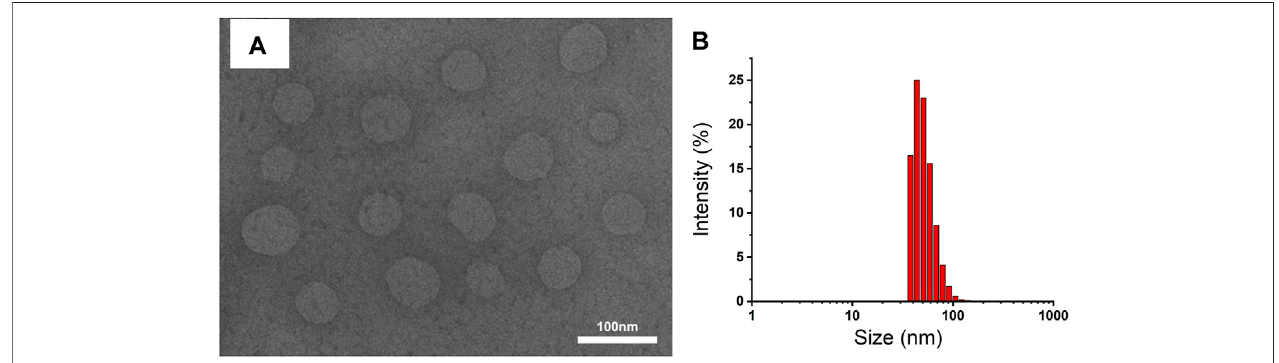
FIGURE 2 | (A) TEM image and (B) size distribution of HES-CUR